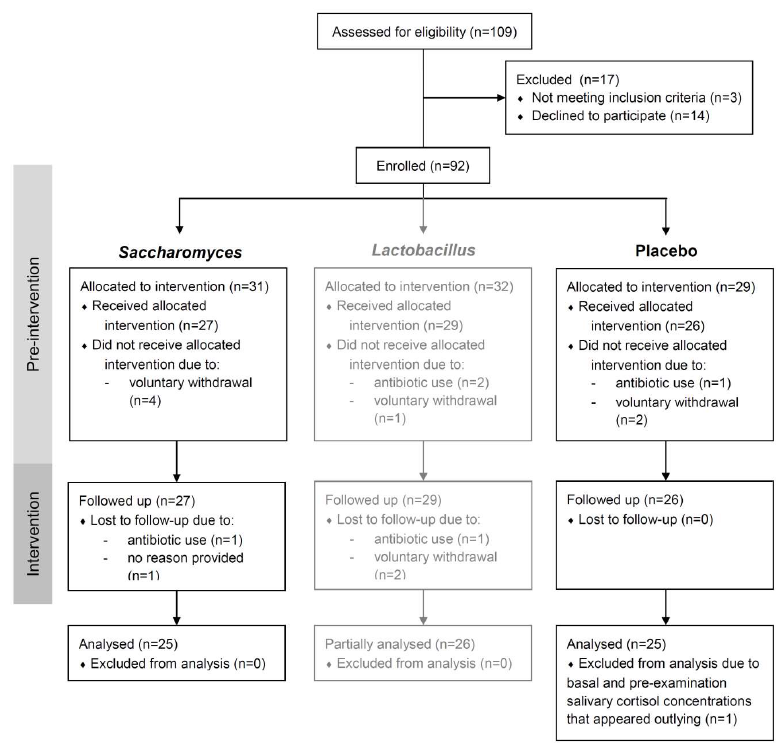
Figure 2. Study flow diagram.